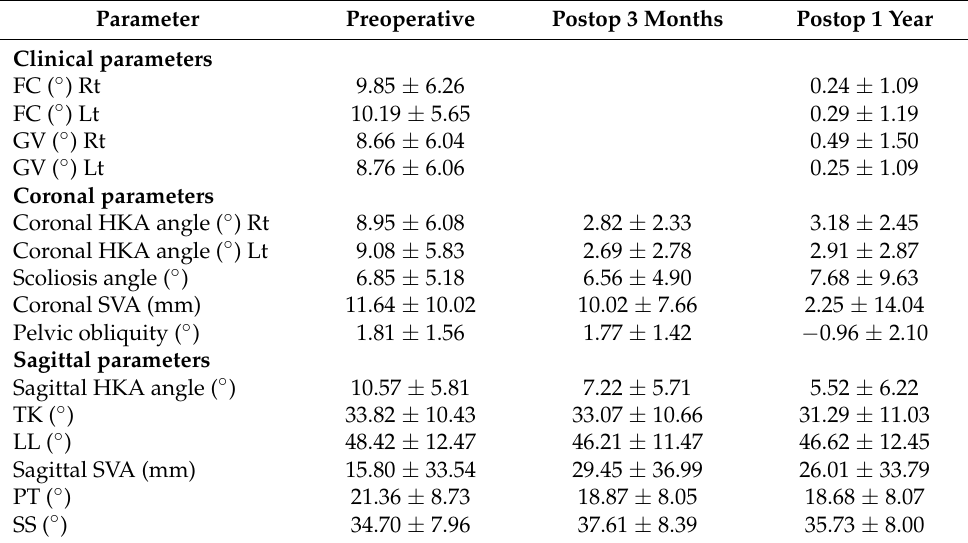
Table 1. Data of all the coronal and sagittal parameters.